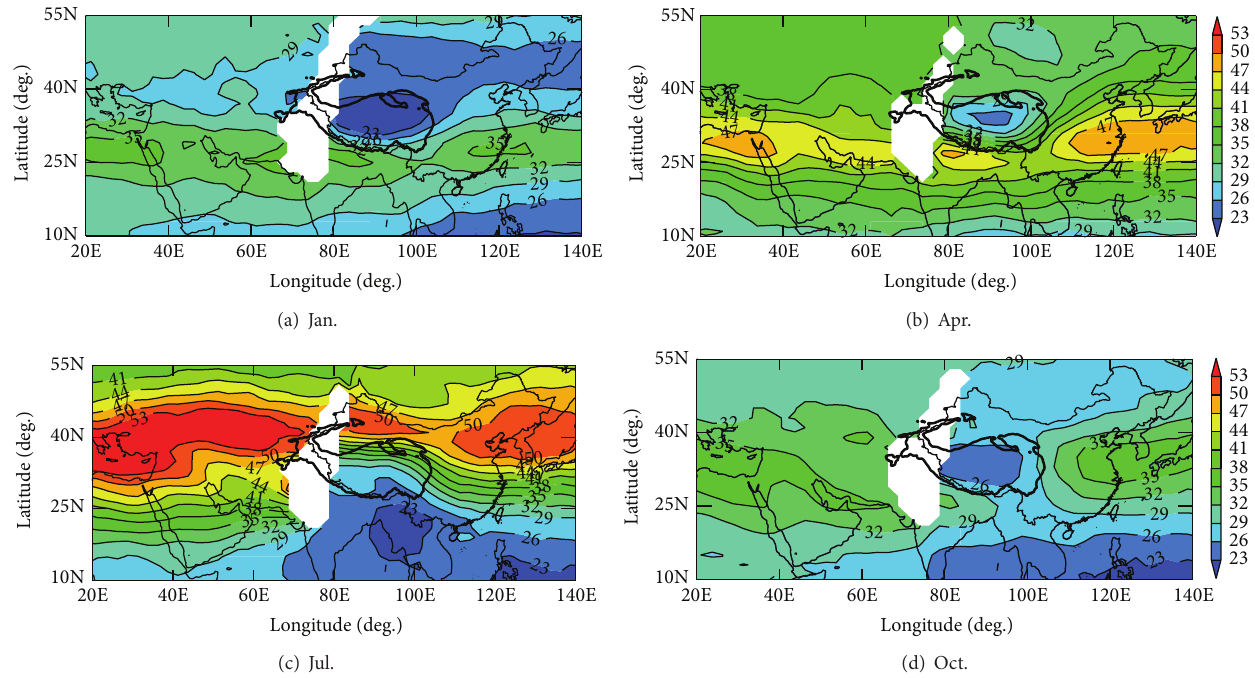
Figure 1: Monthly mean tropospheric column ozone (TCO) (unit: Dobson unit (DU)) from GOME (Global Ozone Monitoring Experiment) measurements between March 1996 and June 2003. GOME data are unavailable over the white area due to the lack of downlinking of GOME data to ground stations. The dark thick contours are coastline and the edge of Tibetan